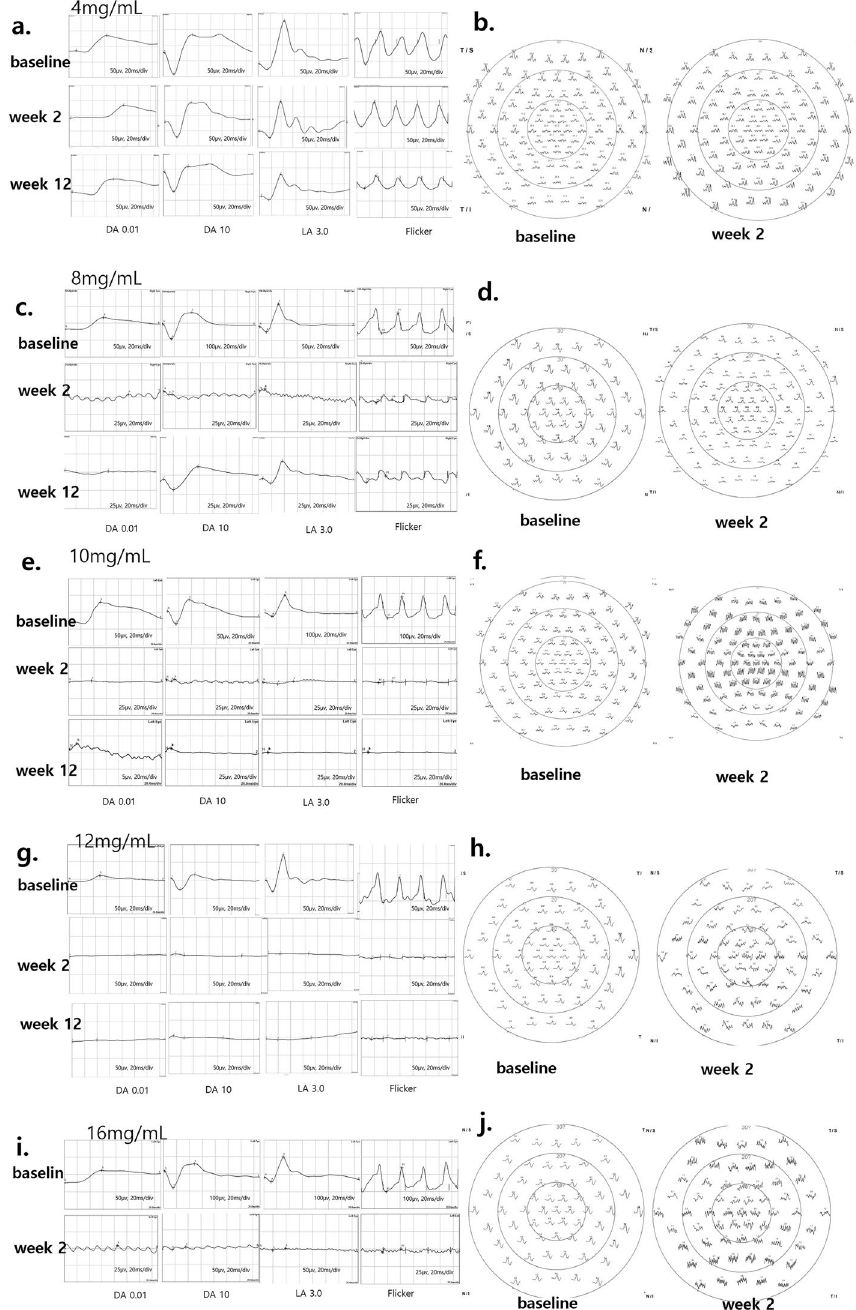
Figure 1. ffERG and mfERG findings of the retina in one case of each 4 mg/mL, 8 mg/mL, 10 mg/mL, 12 mg/ mL, and 16 mg/mL MNU. ( a ) The DA 10.0 a-wave amplitude at baseline and week 2 was 25.4 µV and 26.1 µV, respectively, in the 4 mg/mL MNU case. ( b ) mfERG in the 4 mg/mL MNU showed no signal flattening or noise signals at week 2. ( c ) The DA 10.0 a-wave amplitude at baseline and week 2 was 89.3 µV and 10.1 µV, respectively, in the 8 mg/mL MNU case. The amplitudes in scotopic and photopic ffERG decreased at week 2, but no signal was flat or appeared as noise, especially in photopic ffERG. ( d ) mfERG in the 8 mg/mL MNU case showed focal noise signal and signal flattening at week 2. ( e ) The DA 10.0 a-wave amplitude at baseline and week 2 was 38.6 µV and 6.21 µV, respectively, in a 10 mg/mL MNU case. All signals of ffERG showed nearly flat down signals or noise signals at week 2. ( f ) The mfERG in a 10 mg/mL MNU case showed only noise signals at week 2. ( g ) The DA 10.0 a-wave amplitude at baseline and week 2 was 61.3 µV and 5.67 µV, respectively, in a 12 mg/mL MNU case. All signals of ffERG showed nearly flat down signals or noise signals at week 2. ( h ) The mfERG in a 12 mg/mL MNU case showed only noise signals at week 2. ( i , j ) Both ffERGs and mfERGs in a 16 mg/mL MNU case showed noise signals at week 2. ffERG full field electroretinogram, MNU N -methyl- N -nitrosourea, DA dark adaptive, mfERG multifocal